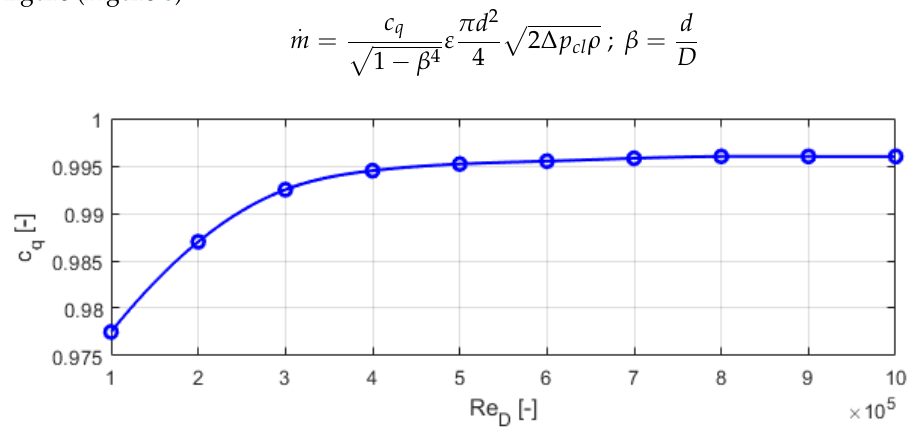
Figure 6. Dependence of the flow coefficient on the Reynolds